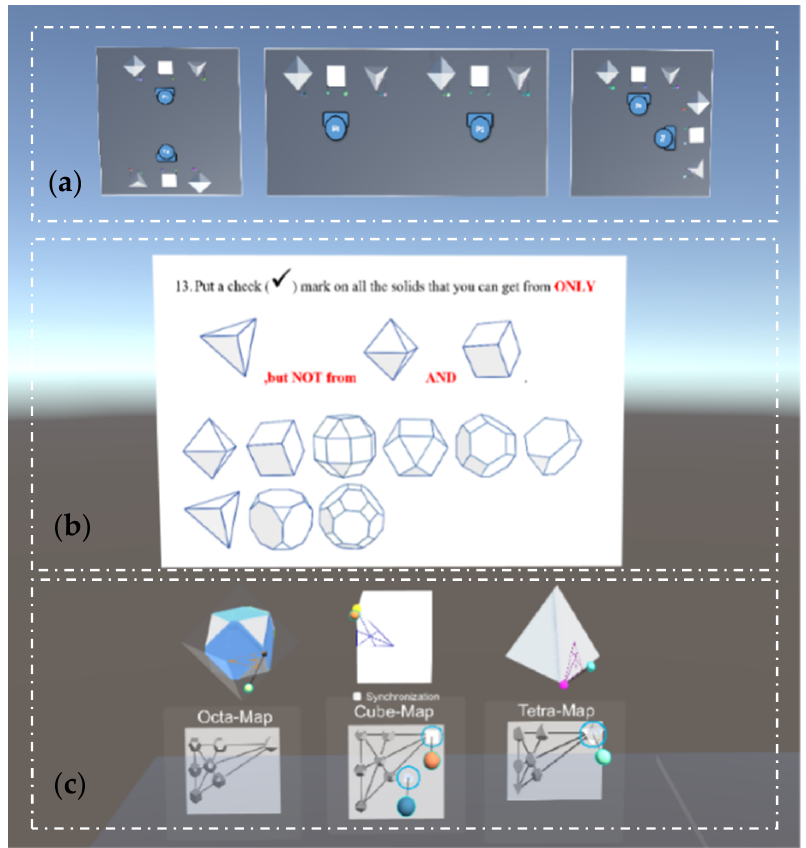
Figure 1. The workspace for an individual user: ( a ) UI indicating current position arrangement; ( b ) task questions to complete; ( c ) interactive 3D solid visualizations.